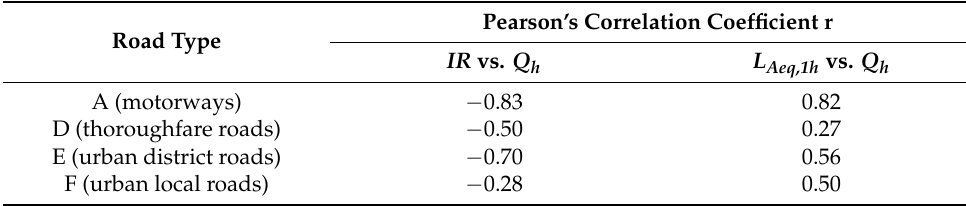
Table 6. Pearson’s correlation coefficients for each road type for IR and L Aeq,1h versus Q h .